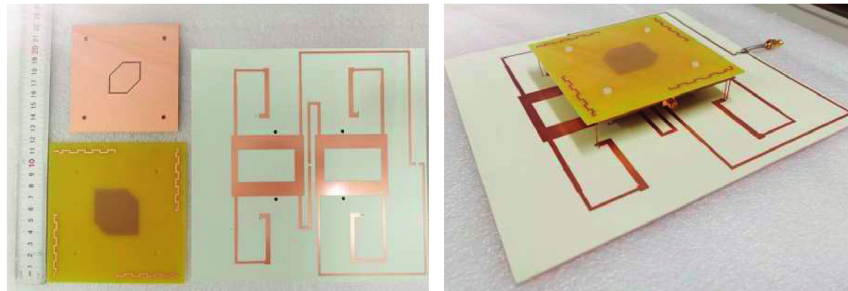
Figure 7: Antenna prototype.